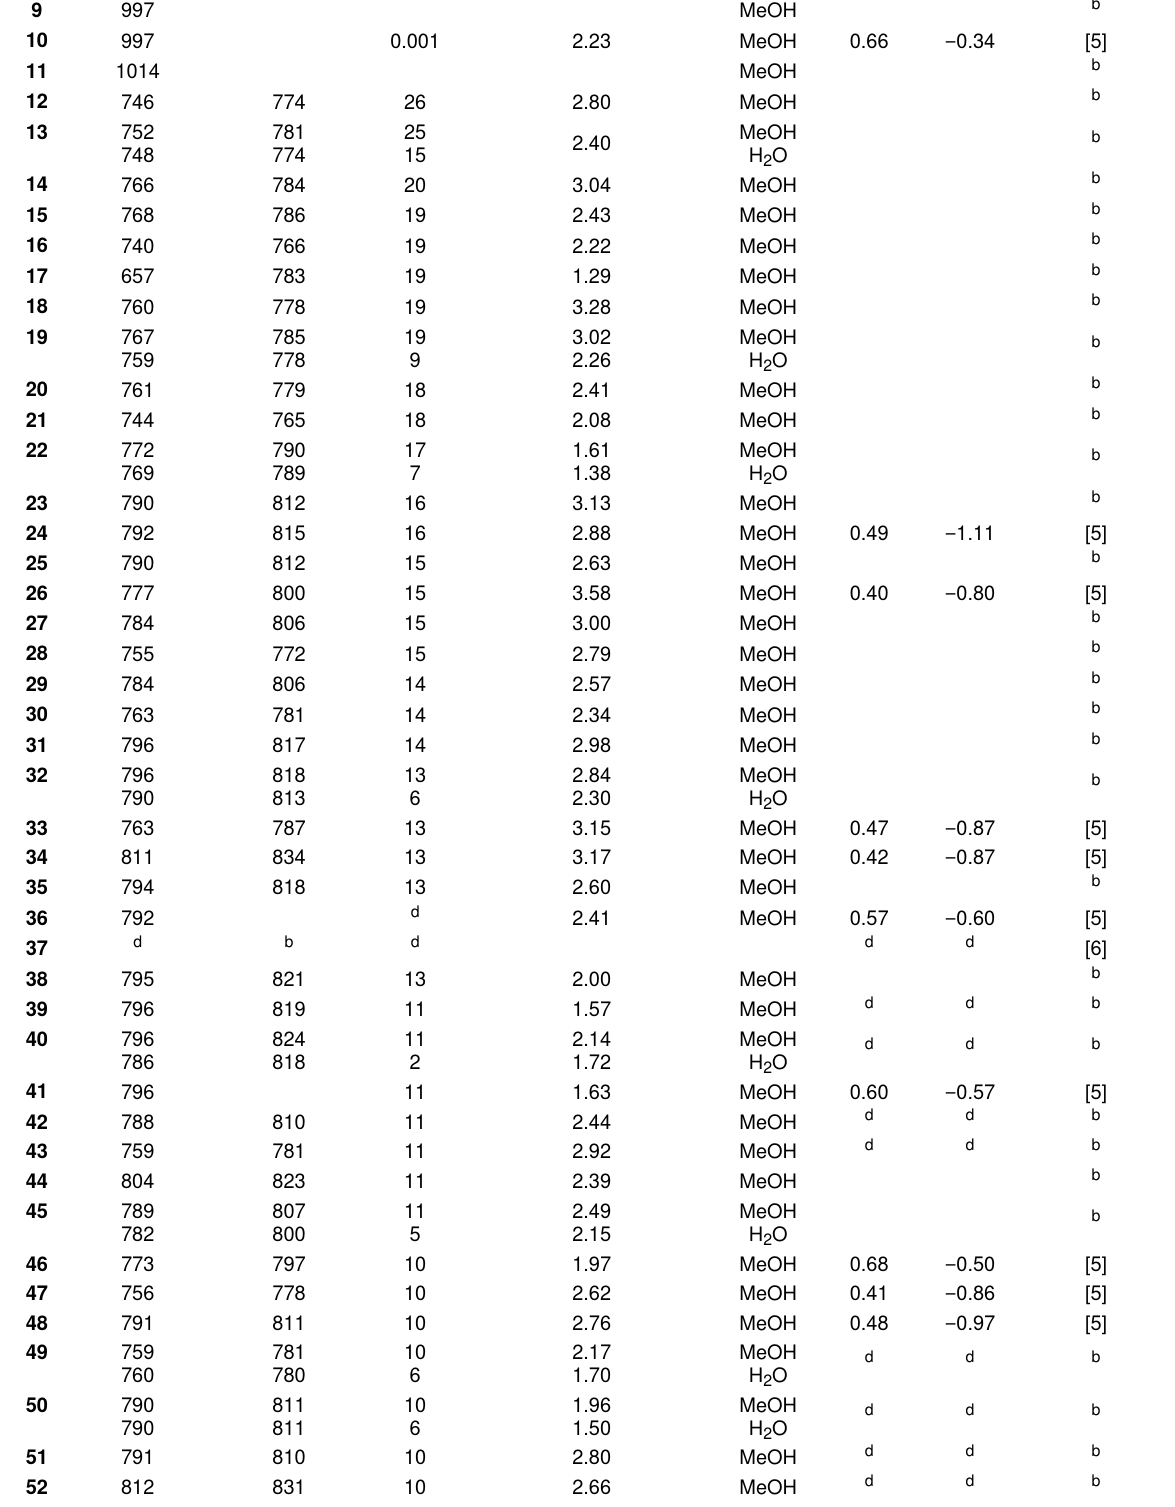
Table 2: Summary of photophysical (absorption maximum λ maxabs , fluorescence maximum λ maxflu , extinction coefficient ε , fluorescence quantum yield Φ f ) and electrochemical data (oxidation potential E ox , and reduction potential E red ). Data of absorbers a relate to the structural patterns I – V . Sup- porting Information File 1 gives information of the electrochemical measurements (data were taken in CH 3 CN), and the determination of photophysi- cal data. The latter complements previously published data [5,6] helping to receive a more completed pattern about these NIR absorbers.